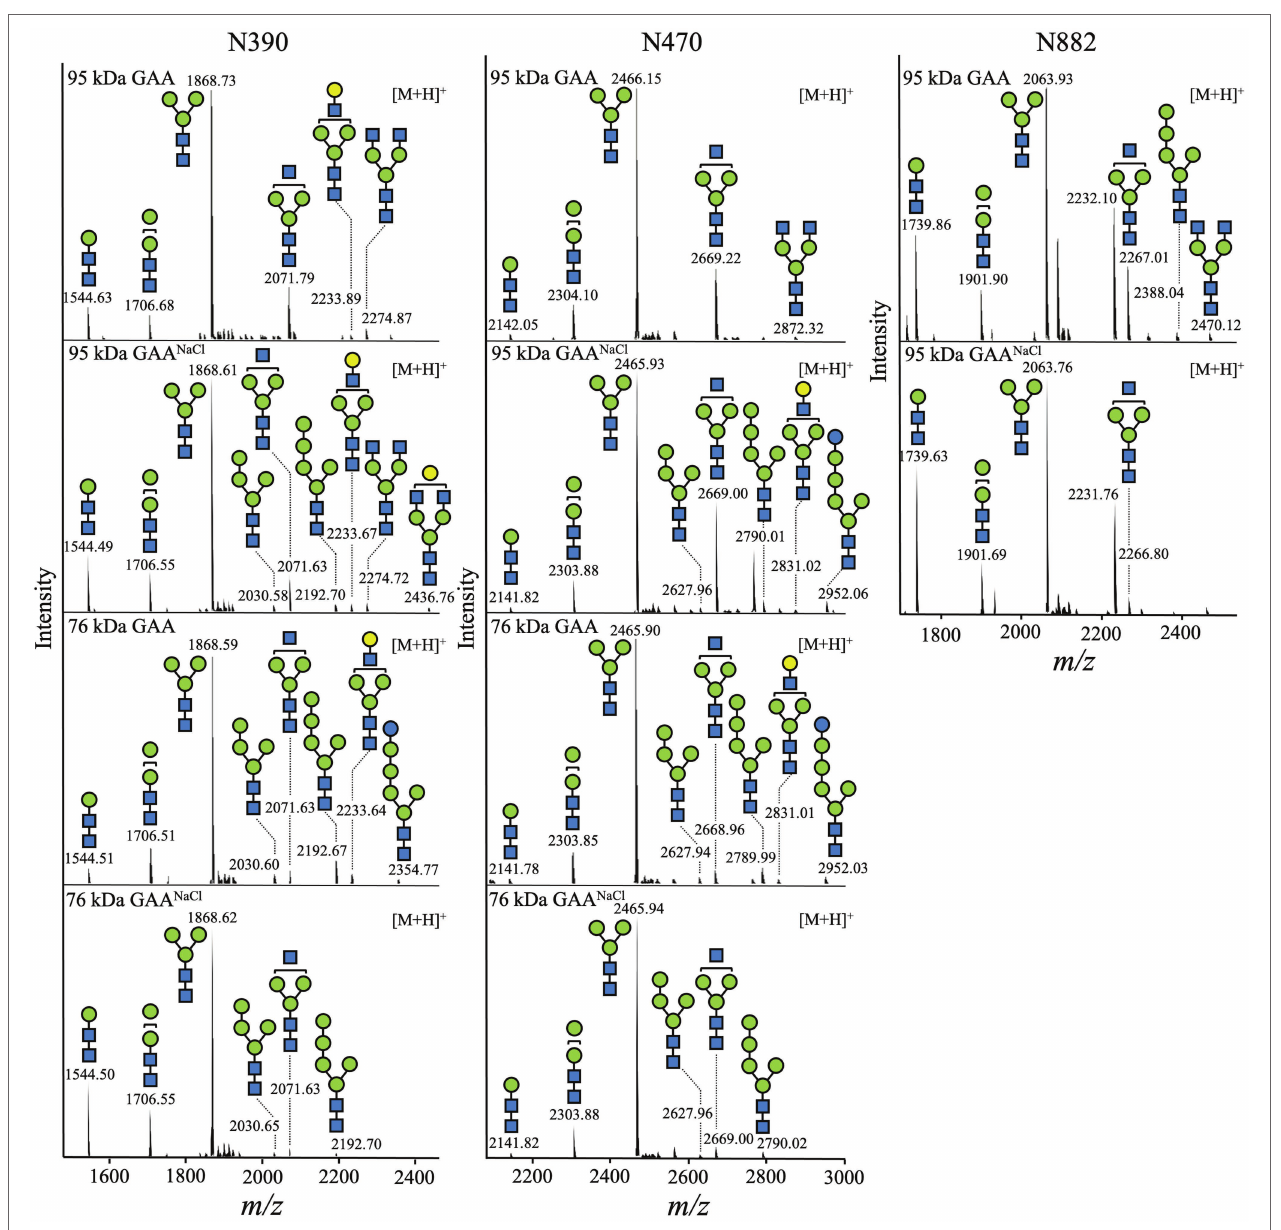
FIGURE 8 | N -glycan profile of GAA produced in Arabidopsis alg3 cell cultures with and without NaCl supplementation. In the shown deconvoluted MS spectra, the mass [M + H] + of the tryptic glycopeptides carrying N -glycosylation sites (N390, N470, and N882) is